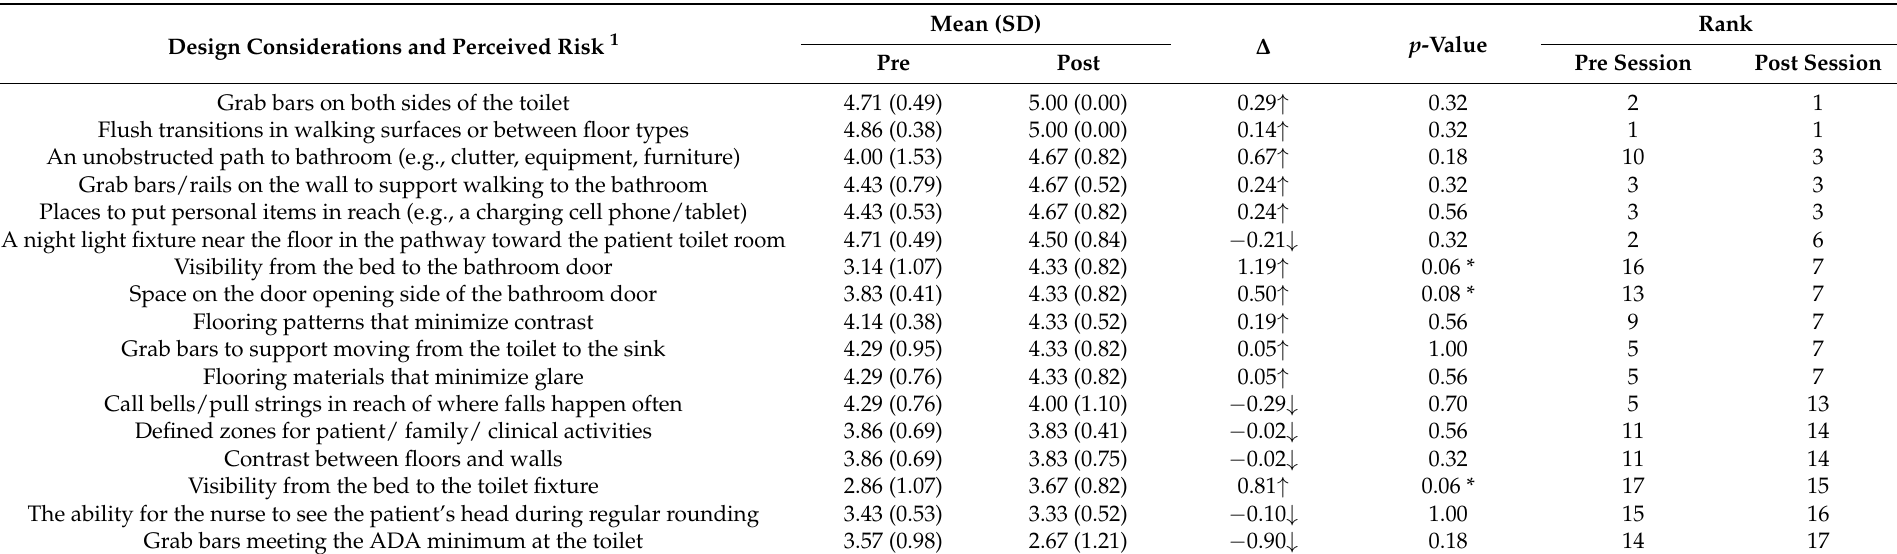
Table 8. Likert-scale survey results, pre- and